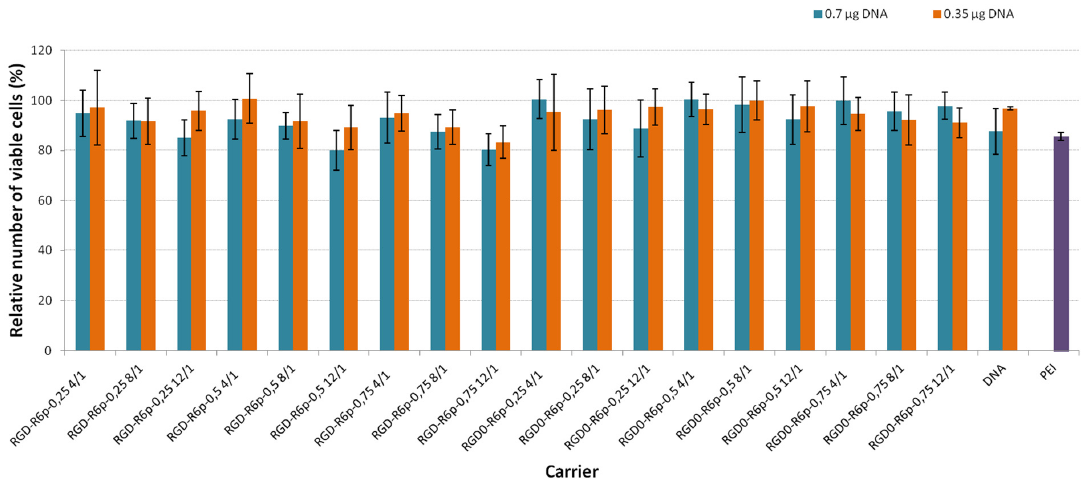
Figure 6. The cytotoxicity after cell transfection with peptide/DNA complexes at 0.7 and 0.35 µg of DNA per well. Values are the mean ± SD of the mean of triplicates.